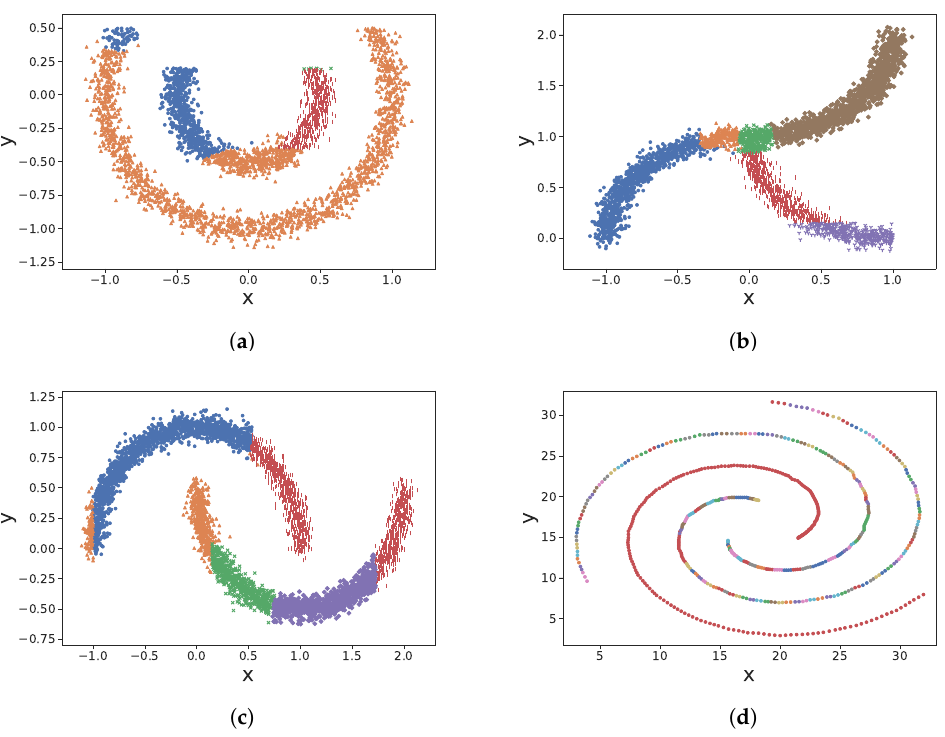
Figure 14. Clustering using SOStream algorithm. ( a ) Clustering with the Horseshoe dataset; ( b ) Clustering with the T dataset; ( c ) Clustering with the Moon dataset; ( d ) Clustering with the Three Spirals dataset.